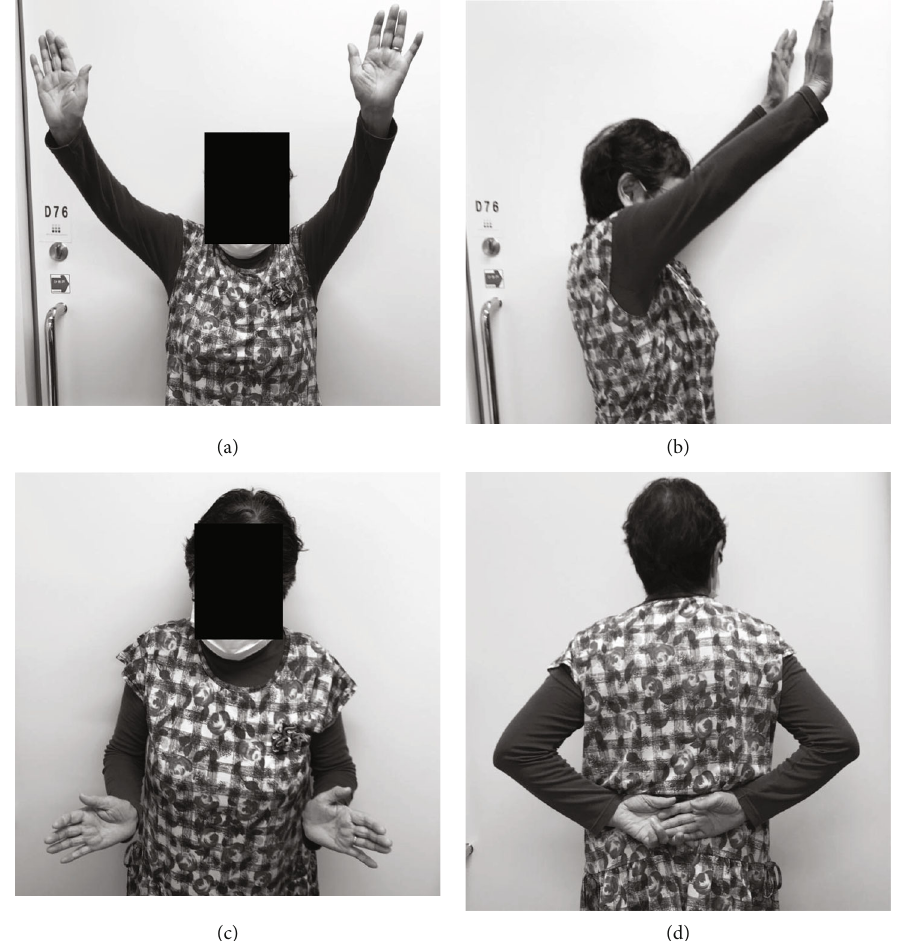
Figure 5: Active shoulder range of motion at the most recent follow-up: (a) forward elevation, (b) abduction, (c) adducted external rotation, and (d) adducted internal